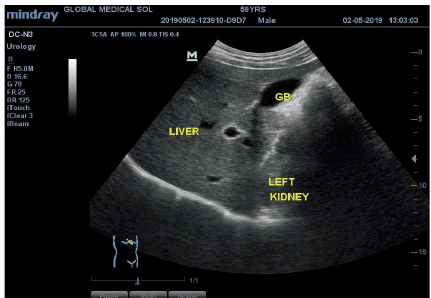
Figure 1: Ultrasound image of the epigastric region in longitudinal plane. This shows a left-sided liver and gallbladder instead of its normal right-sided anatomical position.